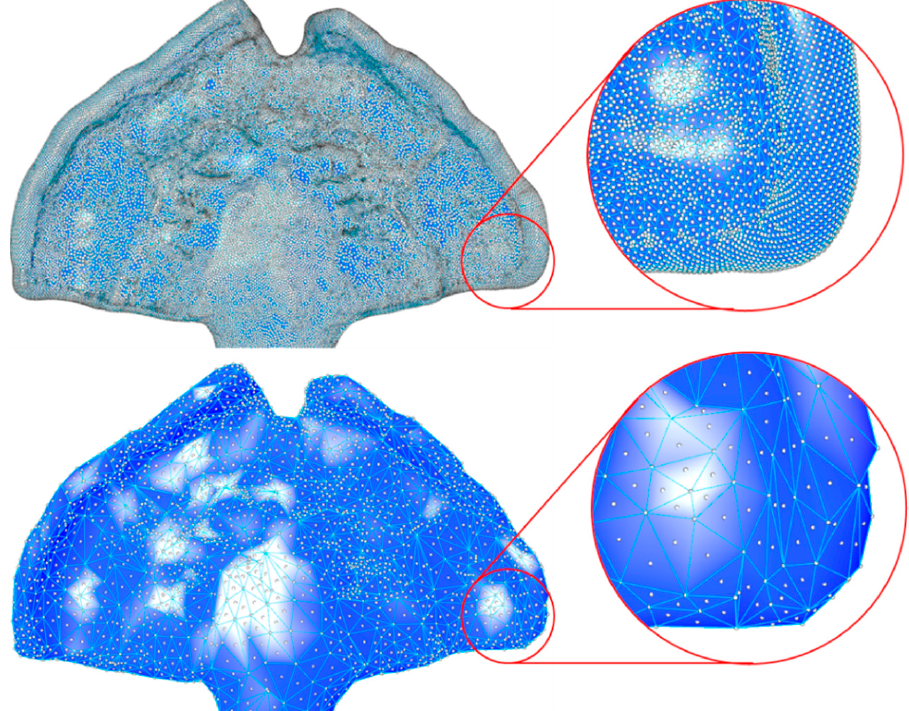
Figure 6. Example of the reduction of mesh face count. Before processing ( top ), the part consisted of 165,000 faces, and after processing ( bottom ), the value was decreased to 3000. The large number of face centres and vertices (baked Rhino objects as white points) makes selection of landmarks and the visualization of the part difficult.